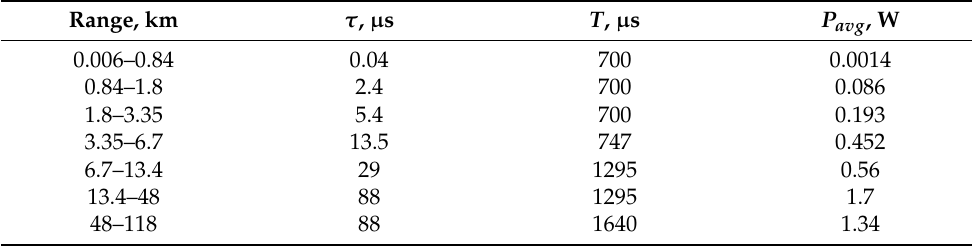
Table 2. Average power dependency to range of view of Halo3